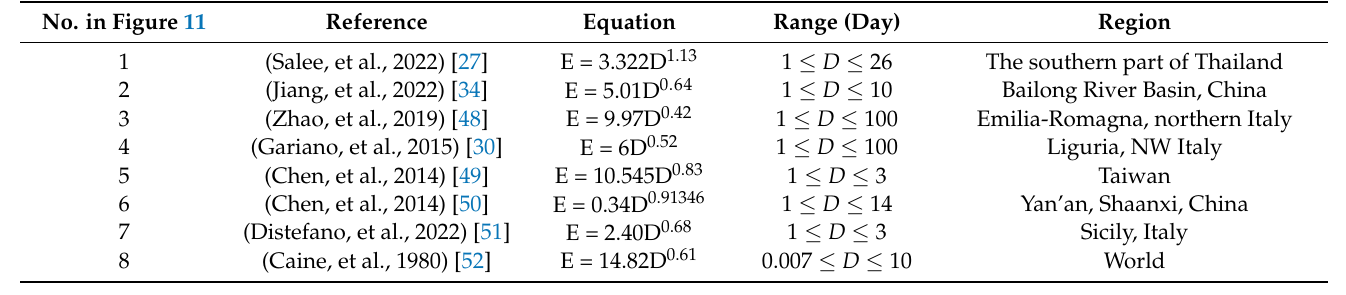
Figure 10. The ROC curves for the E–D threshold and CED threshold.